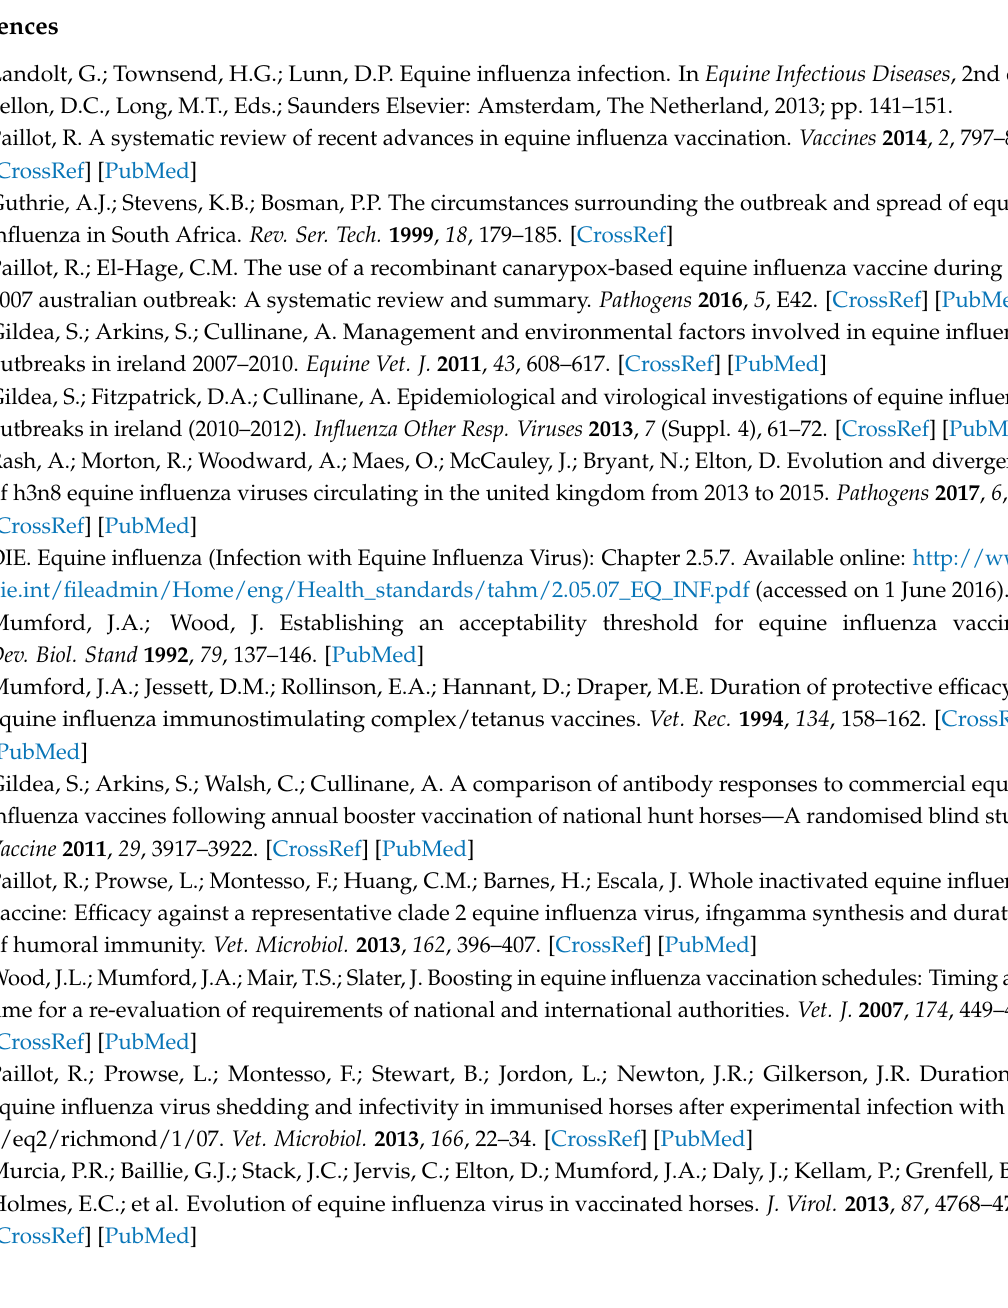
Figure S1: EIV phylogenetic tree, Figure S2: CONSORT flow chart, Table S1: CONSORT check list, Table S2: Virus shedding after experimental